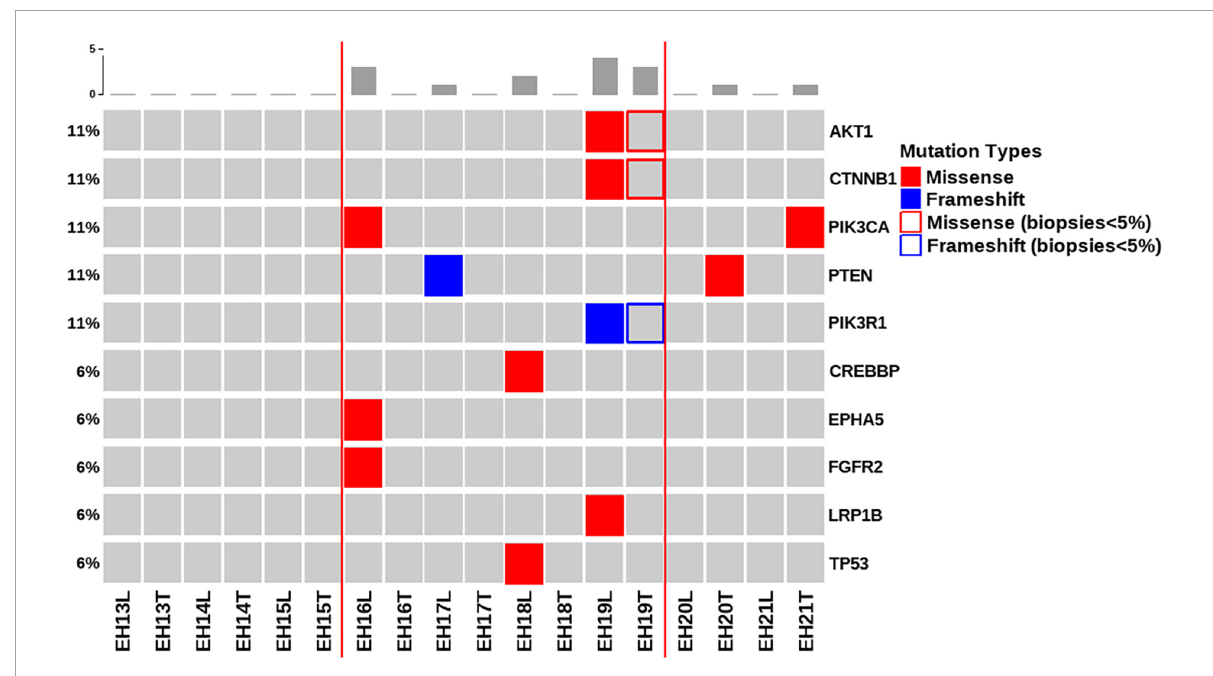
FIGURE2 Distributions of gene mutations identified in endometrial lavage samples and tissue specimens obtained from women with non-atypical endometrial hyperplasia. Red lines indicate the concordance category (mutations identified in endometrial lavage samples and tissue specimens; mutations in endometrial lavage samples only, and mutations in tissue specimens only). The boxes indicate that the allele frequency of mutations in tissue samples was below the filtering threshold, while being present in lavage samples with a high allele frequency.